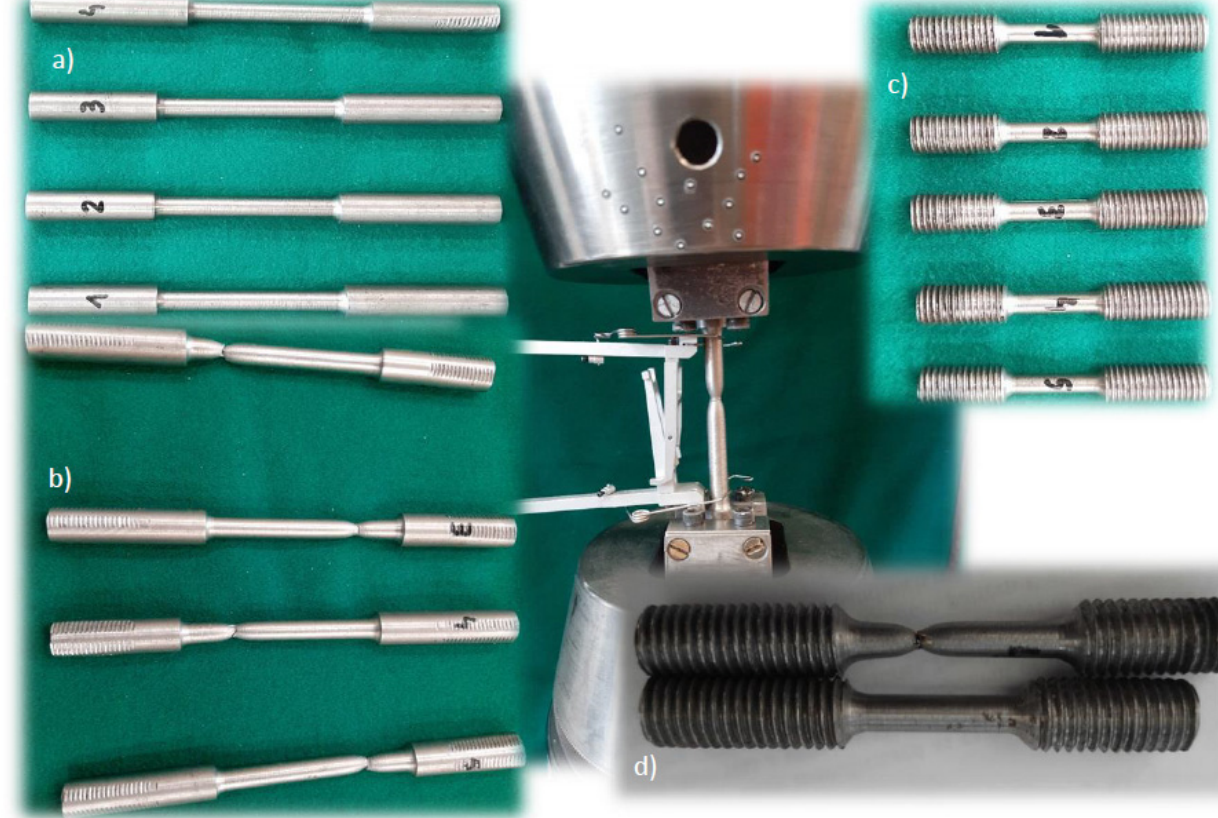
Figure 3. HY 80 steel specimens for static and dynamic tests: ( a ) samples for static tests on the MTS machine; ( b ) samples for static tests after fracture; ( c ) samples for dynamic tests on a rotary hammer; ( d ) samples for dynamic tests after fracture.